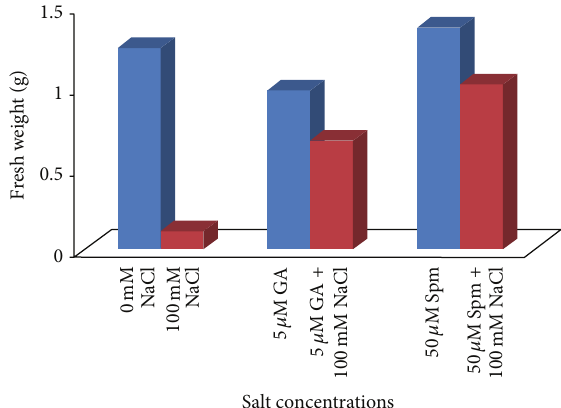
Figure3:EffectofNaClonthefreshweightof10-day-oldmungbean seedling and its possible amelioration with 5 𝜇 M GA 3 and 50 𝜇 M Spm.